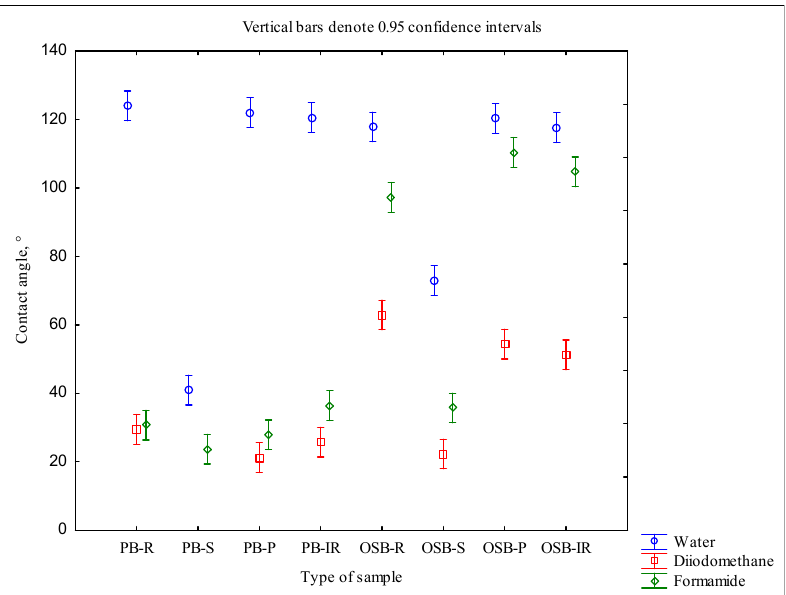
Figure 1. Contact angle of water, diiodomethane and formamide on particleboard and OSB samples (PB-R: raw particleboard, PB-S: sanded particleboard, PB-P: re-pressed particleboard, PB-IR: heated particleboard, OSB-R: raw OSB, OSB-S: sanded OSB, OSB-P: re-pressed OSB, and OSB-IR: heated OSB).